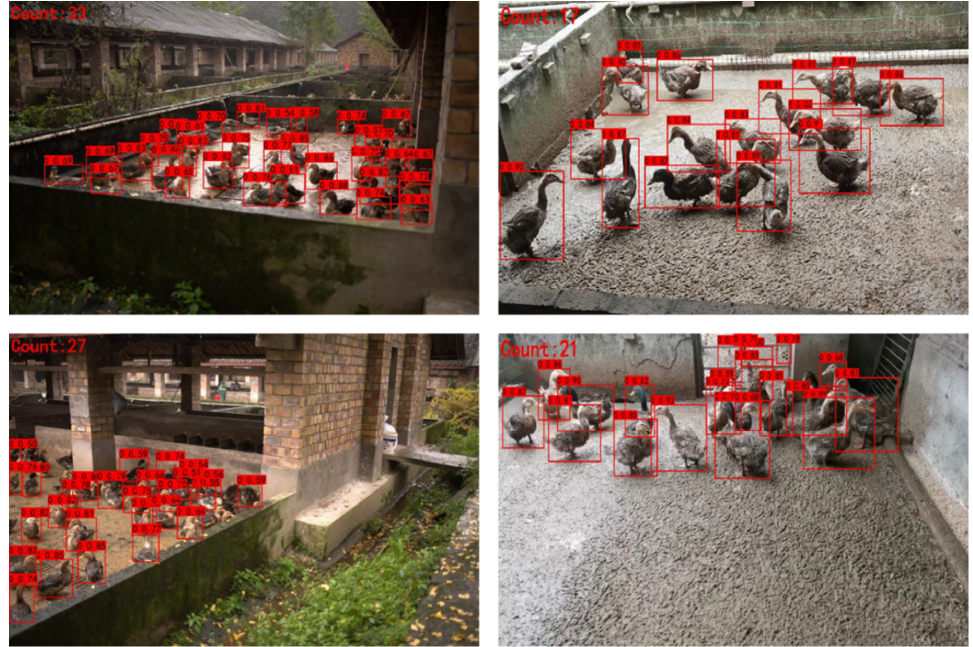
Figure 10. CBAM-YOLOv7 network prediction result